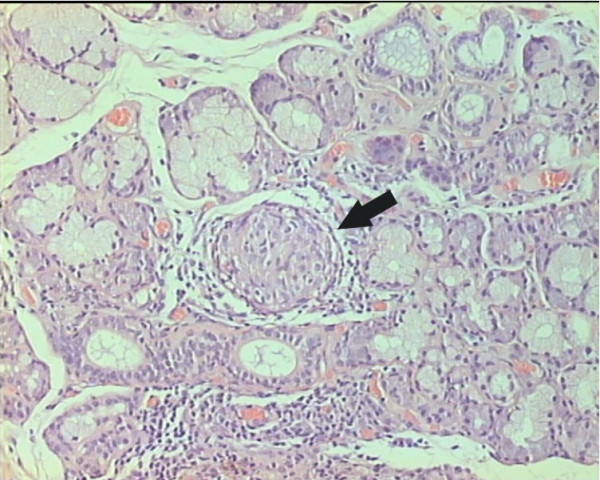
A labial biopsy reveals lobules of small salivary glands and a small, non-necrotic, sarcoid type epithelioid granuloma (arrow). (Haematoxylin & Eosin, original magnification ×100).